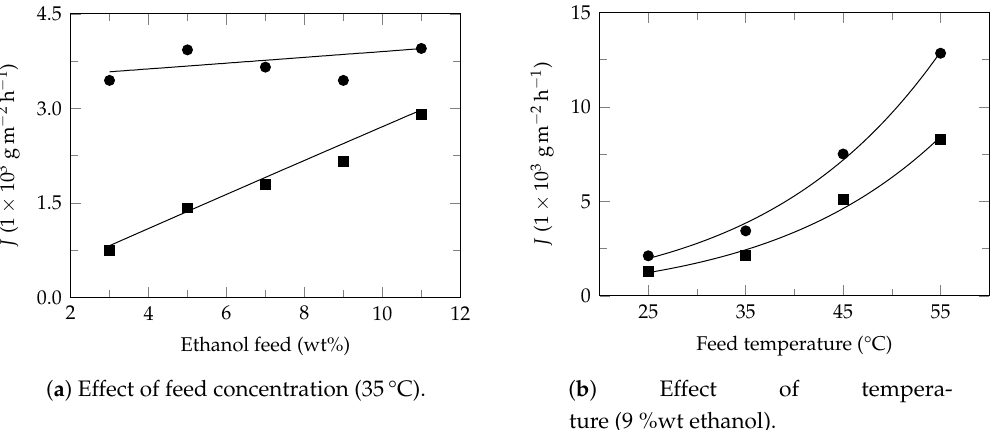
Figure 12. Ethanol recovery. Experimental data extracted from Jia et al. 2019 [80]. Experimental flux: ethanol ( (cid:4) ) and